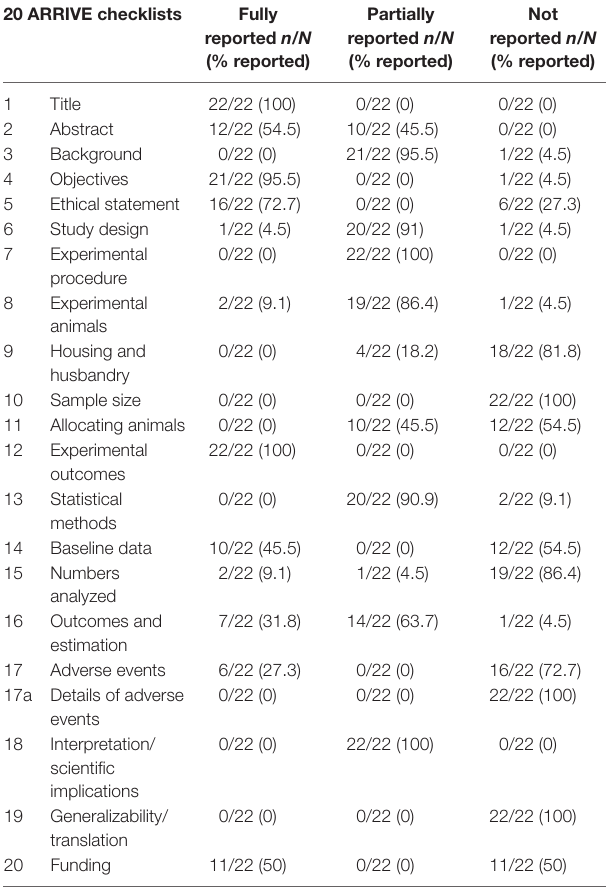
taBLe 2 | ARRIVE checklists of included